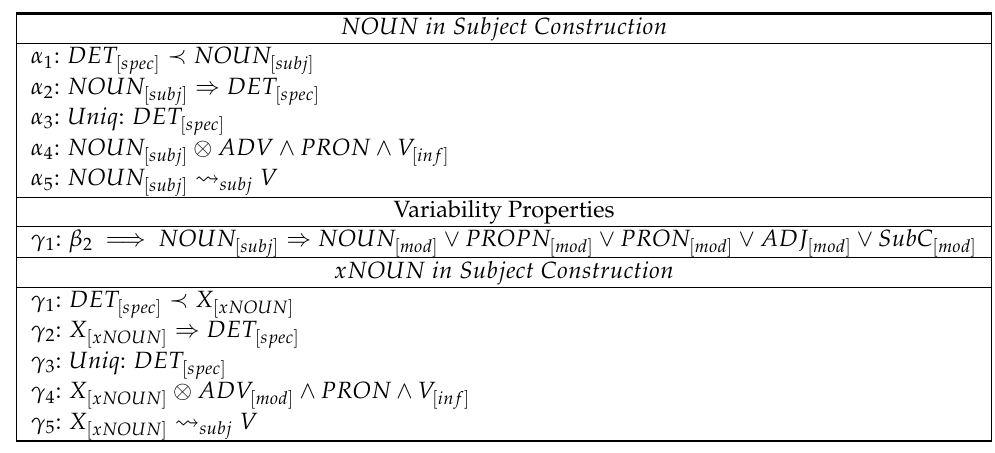
Table 6. Spanish properties of NOUN in subject